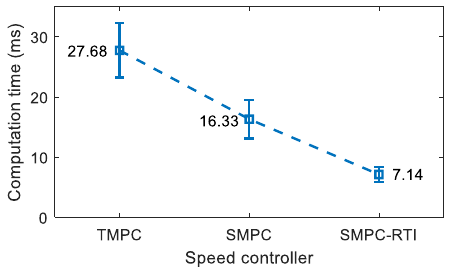
Figure 15. Computation-time statistics for speed controllers.